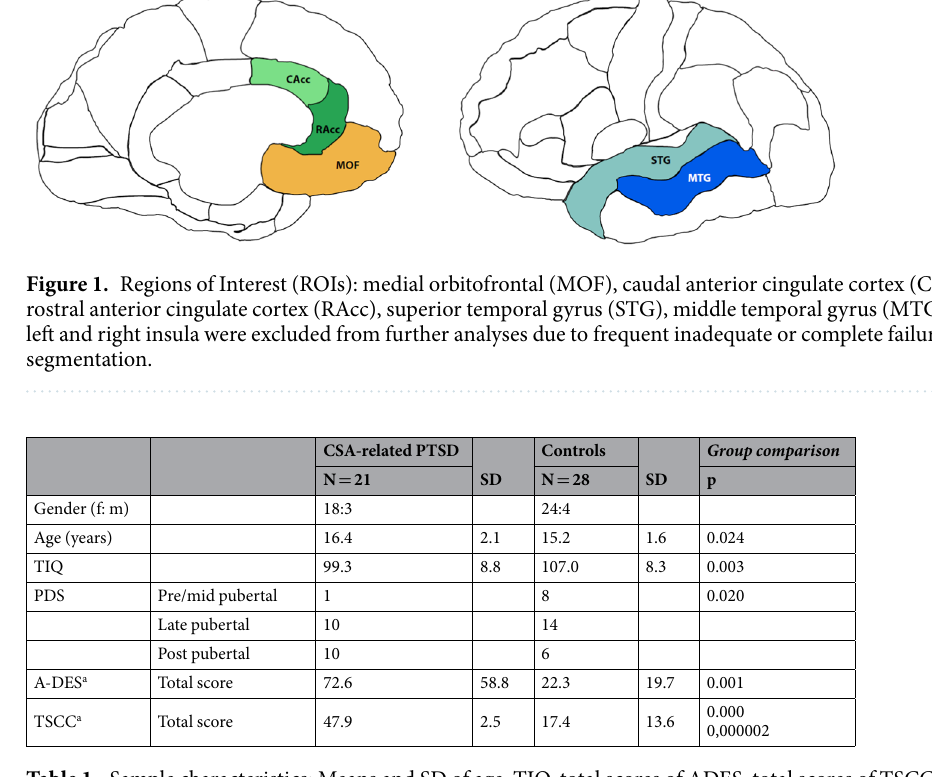
Table 1. Sample characteristics: Means and SD of age, TIQ, total scores of ADES, total scores of TSCC, and numbers per gender and PDS ratings. Abbreviations: CSA, Childhood Sexual Abuse; PTSD, Post Traumatic Stress Disorder; TIQ, Total Intelligence Quotient; PDS, Puberty Development Scale; A-DES, Adolescent Dissociative Experiences Scale; TSCC, Trauma Symptom Checklist for Children. a 4 did not complete the A-DES and